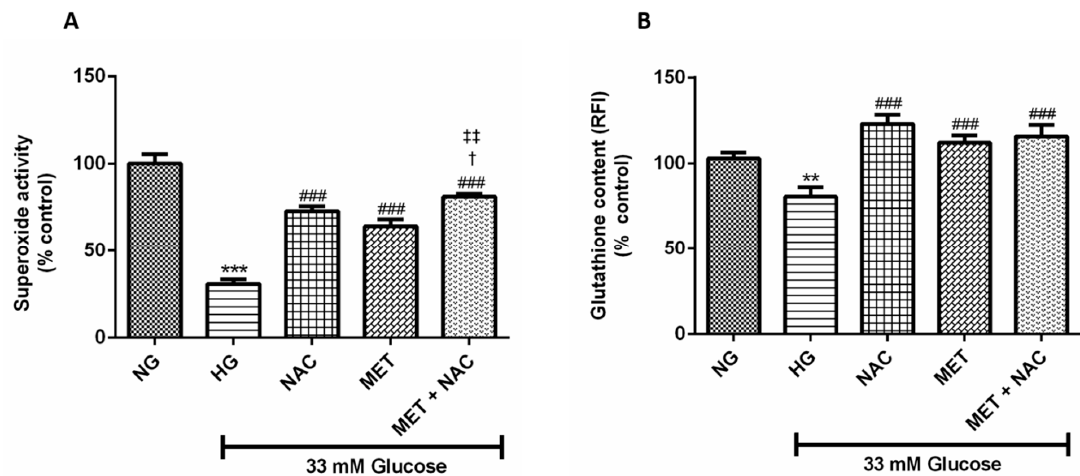
Figure 6. The combination e ff ect of Metformin (MET) and N-acetylcysteine (NAC) on ( A ) superoxide dismutase (SOD) and ( B ) glutathione (GSH) content. H9c2 cardiomyoblasts were cultured in high glucose (HG; 33 mM) for 24 h. Cells were then-treated with NAC (1 mM), metformin (MET) (1 µ M) and a combination of MET + NAC. Cells treated with normal glucose (NG) served as the vehicle control. Data are expressed as the mean ± SEM of 3 distinct biological experiments with each experiment having 3 technical replicates ( n = 9). Significance is depicted as ** p ≤ 0.01, *** p ≤ 0.001 versus NG control, ### p ≤ 0.001 versus HG control, † p < 0.05 versus NAC and ‡‡ p ≤ 0.01 versus MET.